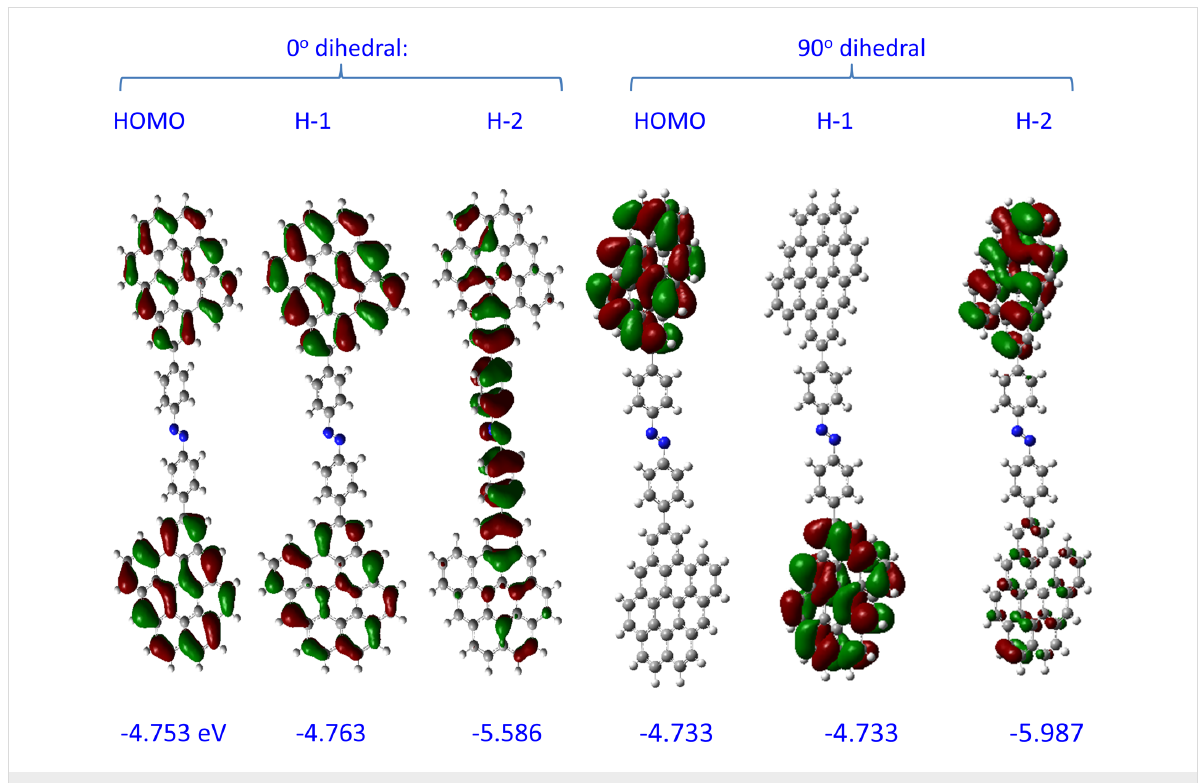
Figure 5: Effect of dihedral angle on orbital electron distributions in G9–AB–G9. In the 0° case, the G9s and AB are coplanar, while in the 90° case the G9s are coplanar but the AB plane is perpendicular to both G9s. Orbital energies are shown below each structure, in eV.